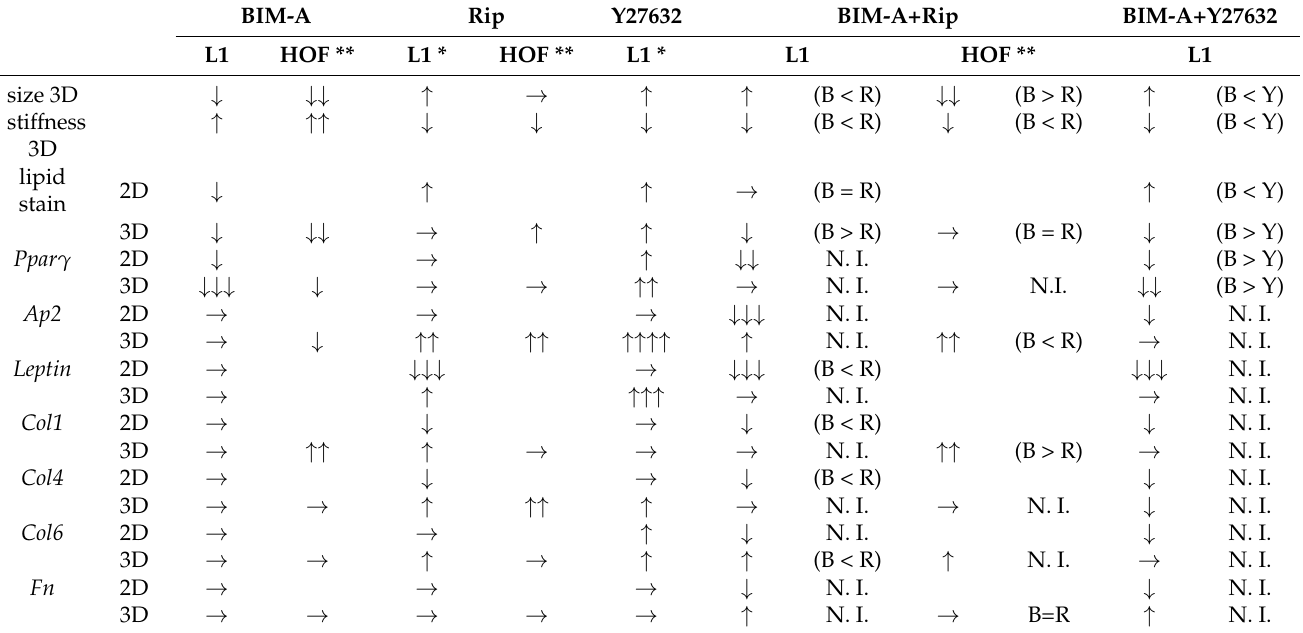
Table 1. Summary of the effects of mono- or combined treatments of PGs and ROCK inhibitors on the physical properties of the 3D 3T3-L1 spheroids, and adipogenesis and gene expression in the